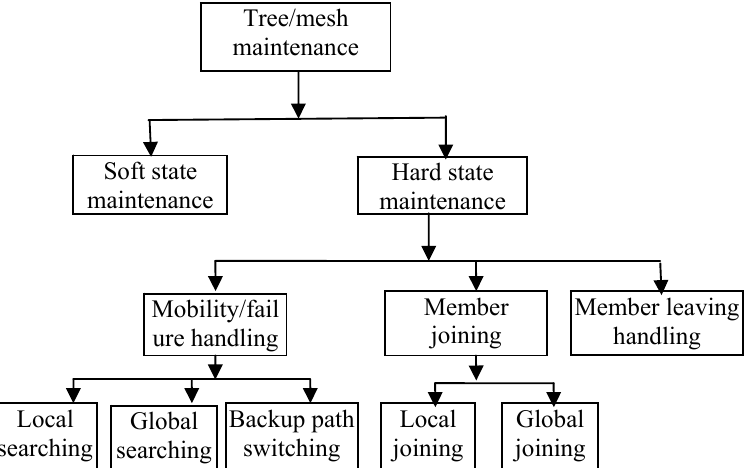
Figure 3. Classification of tree/mesh maintenance